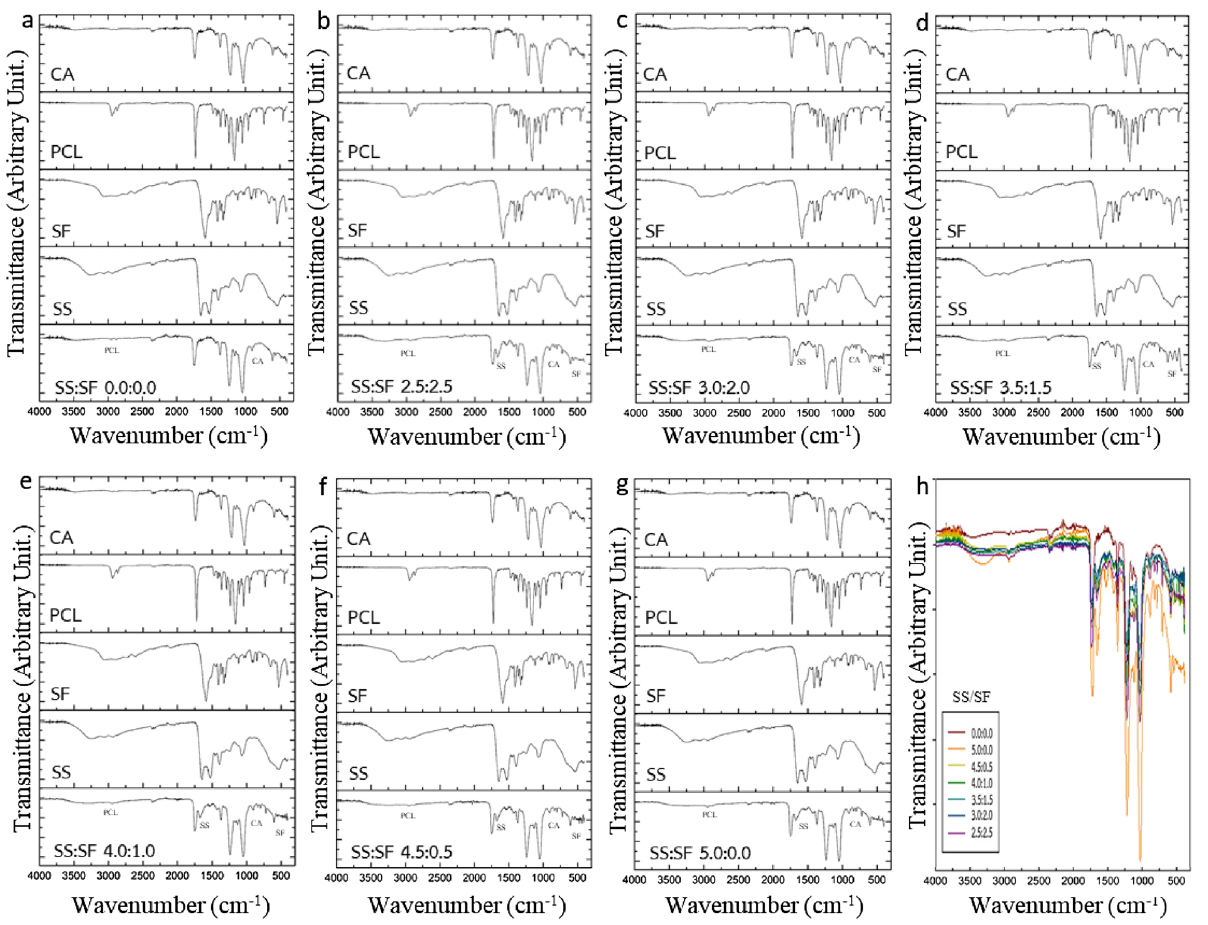
Figure 3. The Fourier-transform infrared (FTIR) spectra of the fabricated nanofiber mats with SS/SF concentration ratio of ( a ) 0.0:0.0 ( b ) 2.5:2.5 ( c ) 3.0:2.0 ( d ) 3.5:1.5 ( e ) 4.0:1.0 ( f ) 4.5:0.5 ( g ) 5.0:0.0 comparing to pure CA, PCL, SF, and SS, and ( h ) is the FTIR spectra comparing of nanofiber mats of all SS and SF concentration ratios.